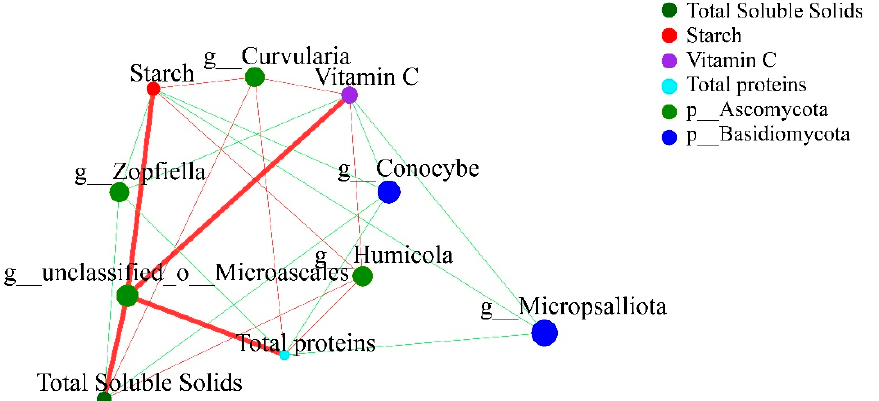
Figure 7. Correlation network analysis of quality characteristics of different pumpkin cultivars and soil fungi at the genus level (top 50).